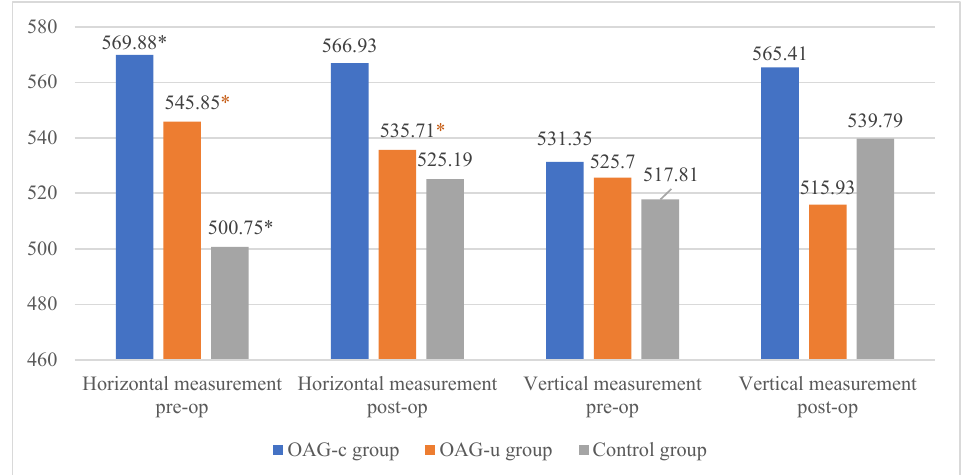
Figure 12. FAZ horizontal and vertical measurements of superficial capillary plexus before and 6 months after cataract surgery. Vertical axis shows mean FAZ horizontal and vertical measurements ( µ m). Statistically significant measurements (*) ( p < 0.05). There were no statistically significant differences in FAZ horizontal and vertical measurements of the deep capillary plexus before and after the cataract surgery in all study groups ( p > 0.05 and p > 0.05). The horizontal measurement of control group subjects